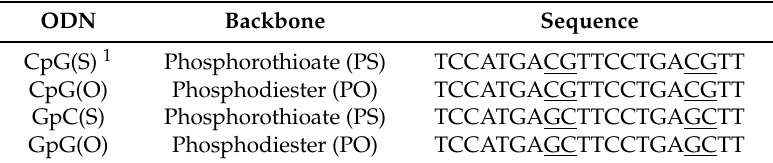
Table 1. Details on oligonucleotide